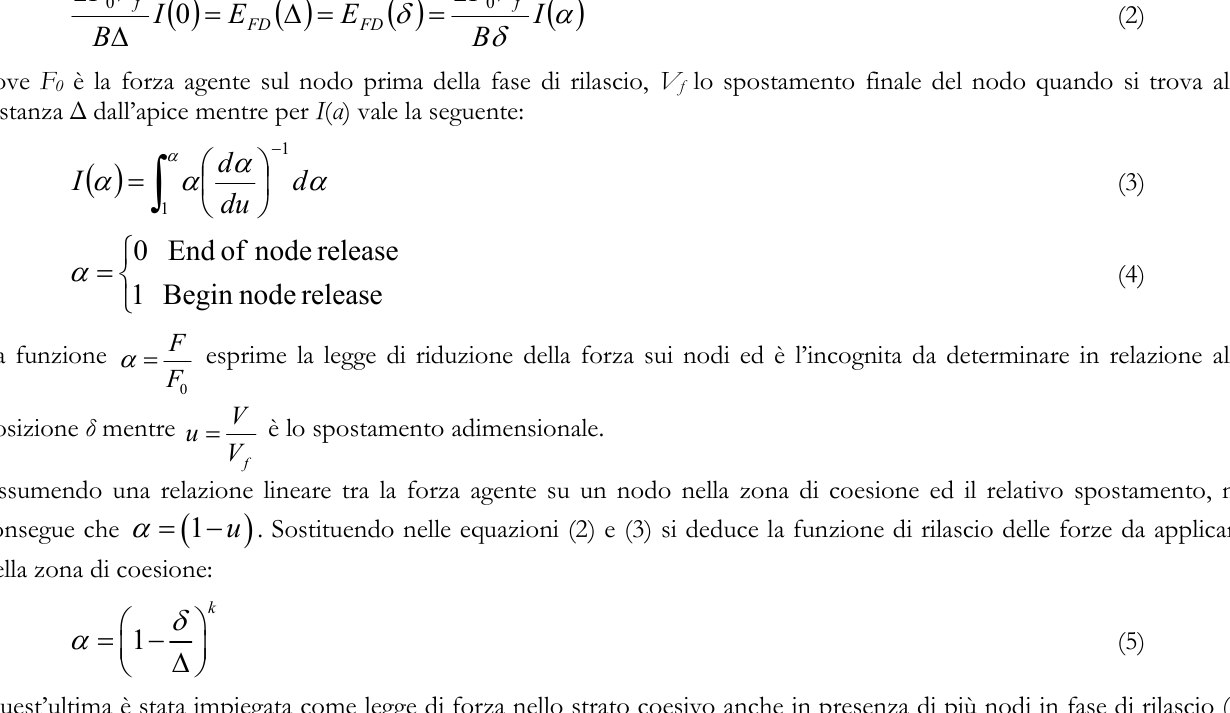
Figura 4: a) Schema teorico del modello coesivo; b) definizione del